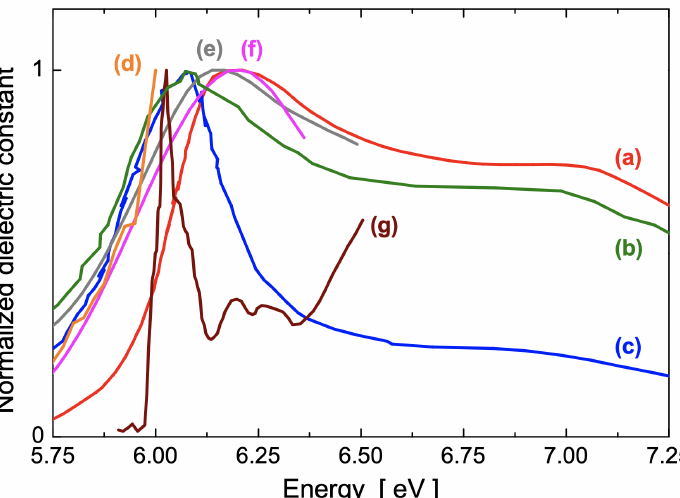
Figure 6. Dielectric constant vs. energy measured at room temperature on powders, bulk crystals and epilayers. Note the distribution of tendencies for the pyrolitic BN ( a – c ), the epilayers ( e , f ) and the bulk hBN crystals ( d , g